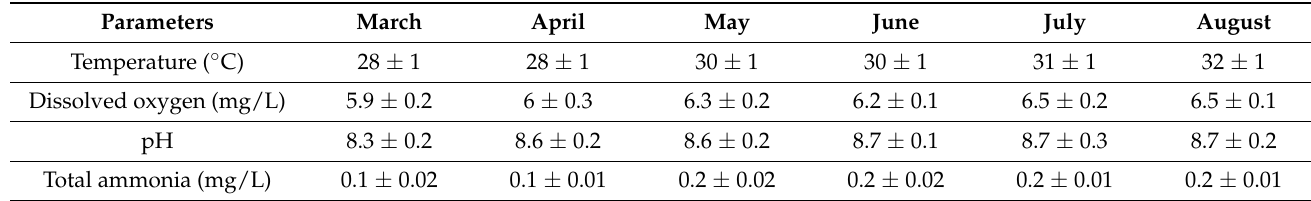
Table 2. Environmental water parameters measured daily in the hatchery during the